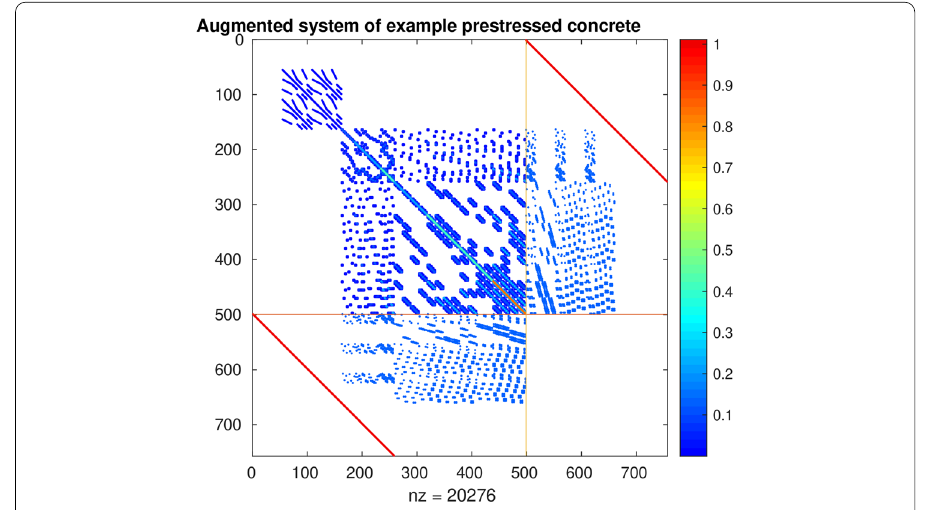
Fig. 6 Saddle point system for prestressed block example